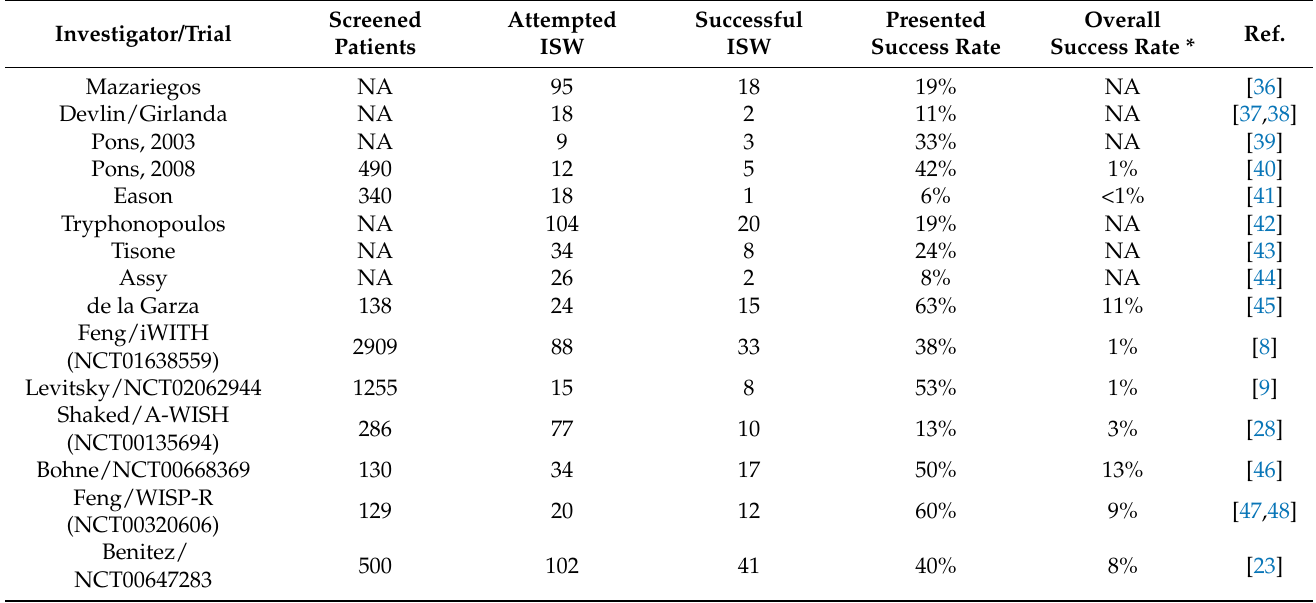
Table 1. Spontaneous operational liver tolerance. Multi-center clinical trials of standard-of-care immunosuppression withdrawal. Investigator/Trial